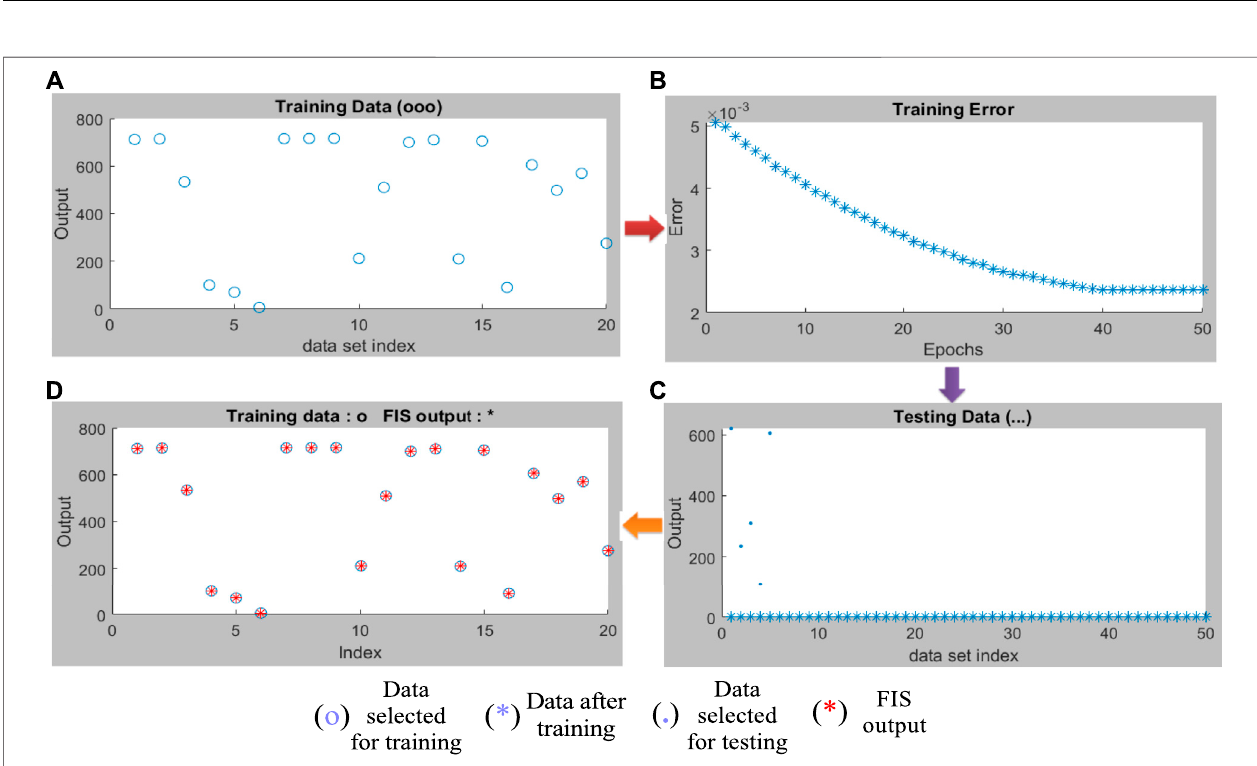
Frontiers in Chemistry |